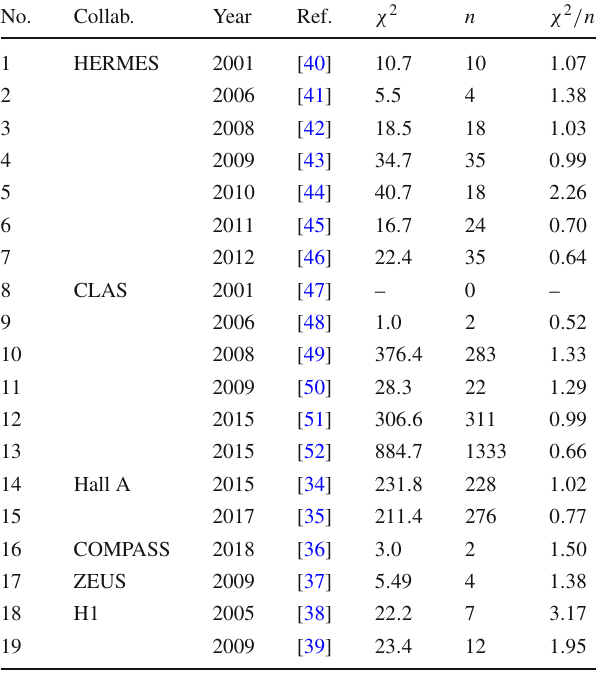
Fig. 11 Coverage of the ( x , Q 2 ) (left) and Bj , − t / Q 2 ) (right) ( x Bj phase-spaces by the experimental data listed in Table 2. The data come from the Hall A ( (cid:2) , (cid:3) ), CLAS ( (cid:4) , (cid:5) ), HERMES ( • , ◦ ), COMPASS ( (cid:6) , (cid:7) ) and HERA H1 and ZEUS ( (cid:8) , ♦ ) experiments. The gray bands (open markers) indicate phase-space areas (experimental points) being excluded from this analysis due to the cuts introduced in Eqs. (22) and (23)